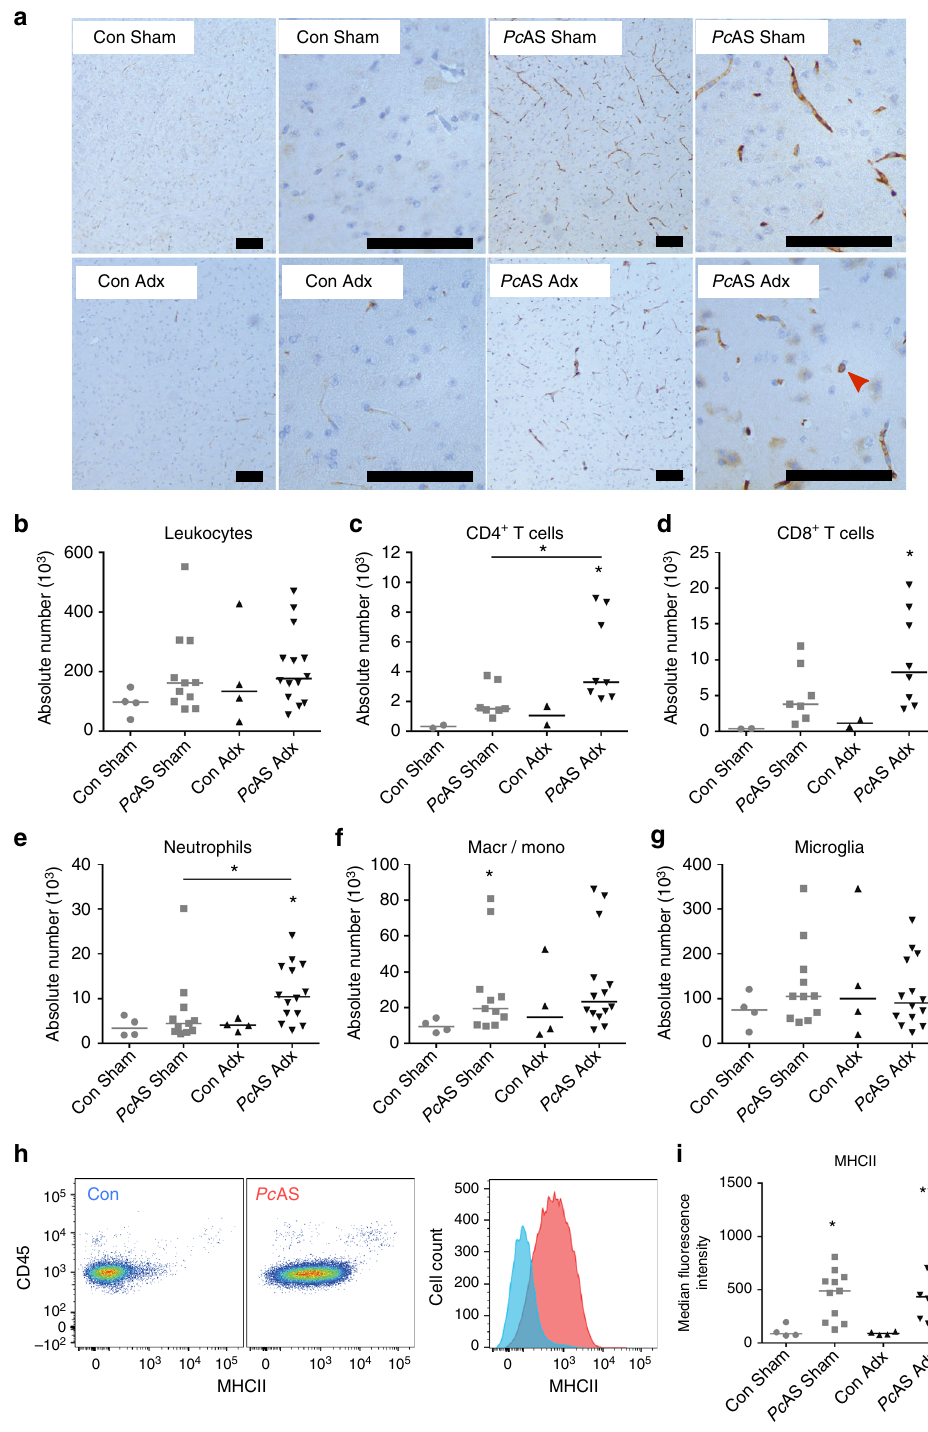
Fig. 4 CD4 + T cell and neutrophil numbers are increased in brains of Adx mice upon infection. Sham and Adx C57BL/6 mice were infected with Pc AS. The mice were euthanized and brains were dissected at 8 to 10 days after infection. a Sections were stained with anti-CD45 monoclonal antibodies (brown) to identify leukocytes. Representative images are shown (original magni fi cation x10 and x40, bar = 100 µ m). The red arrow indicates an occasional leukocyte. b – i Leukocytes were isolated from individual brains and analyzed by fl ow cytometry to identify CD45 + leukocytes. c – f Tmem119 − cells were subdivided into CD4 + T cells (CD3 + CD4 + ), CD8 + T cells (CD3 + CD8 + ), neutrophils (CD11b + Ly6G + F4/80 − ) and macrophages/monocytes (CD11b + F4/80 + ). g Microglia were gated as CD11b + Tmem119 + Ly6G − CD3 − . h – i Characterization of MHC class II expression on microglia. h Plots representing the staining pattern for the indicated markers. Corresponding intensity of MHC class II expression on microglia from a representative control mouse (blue) and a Pc AS infected mouse (red). i Median fl uorescence intensity of MHC class II. Each symbol represents data from an individual mouse. Horizontal lines in between data points represent group medians and analysis was by Mann-Whitney U -test. Horizontal lines with asterisks on top indicate the levels of statistical signi fi cance between the indicated groups. Asterisks above individual data sets indicate the levels of statistical signi fi cance compared to the uninfected control group. Data from two separate experiments. * p < 0.05, ** p < 0.01, *** p <